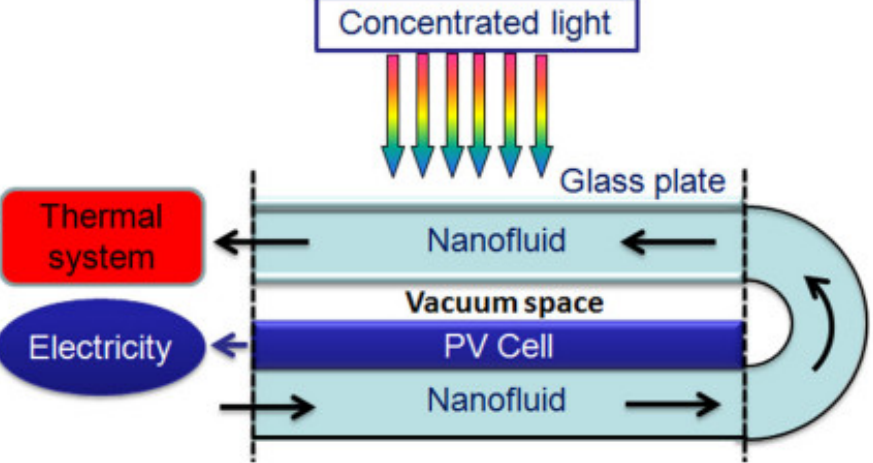
Figure 26. Two-dimensional sketch of the de-coupled PV/T system concept [112]. Reprinted with permission from Ref. [112]. 2015, Elsevier.